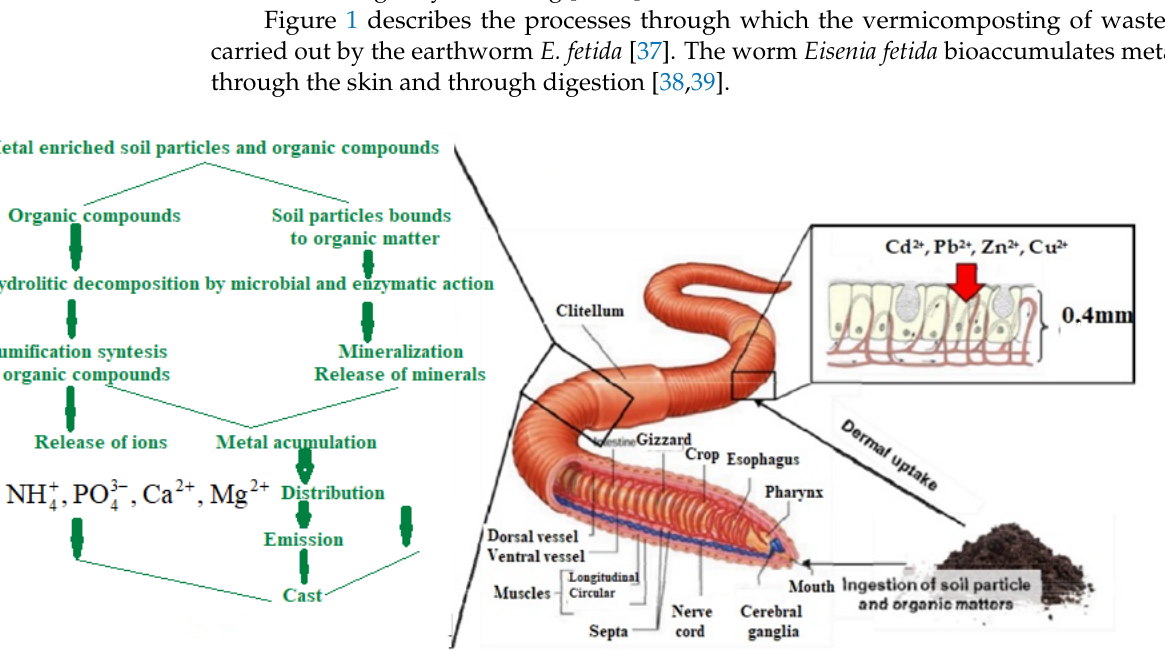
1. Physico ‐ chemical characteristics of simple and vermicomposted SS (data from